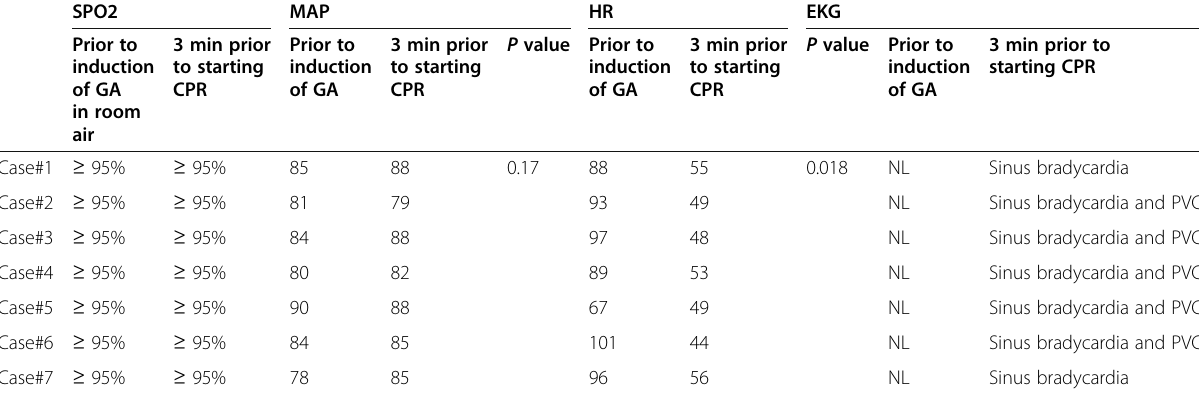
Table 1 Parameters monitoring and changes before induction of anesthesia and during the last 3 min prior to starting standard CPR based on patients ’ records SPO2 MAP HR Prior to